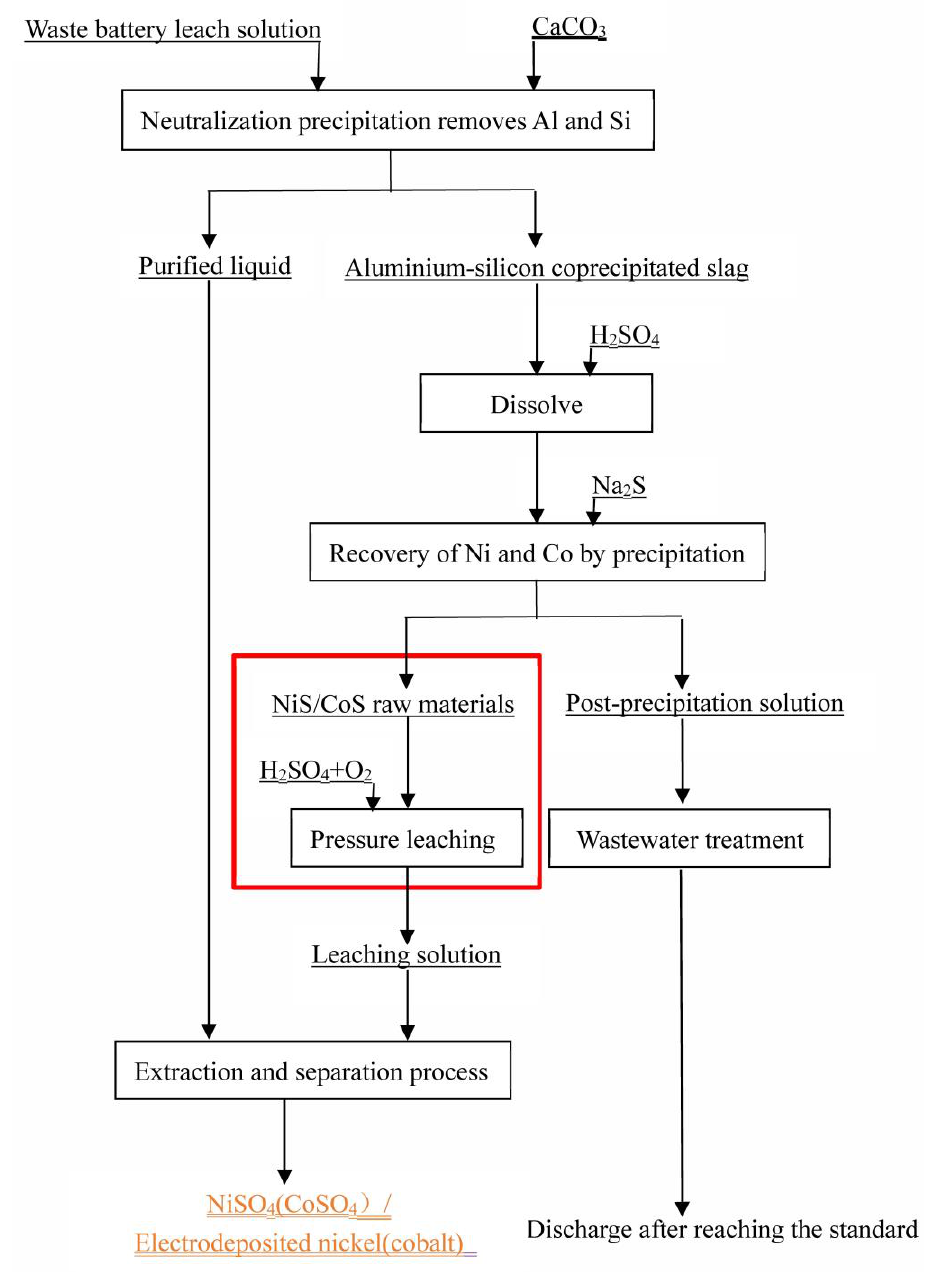
Figure 2. Process flow chart.